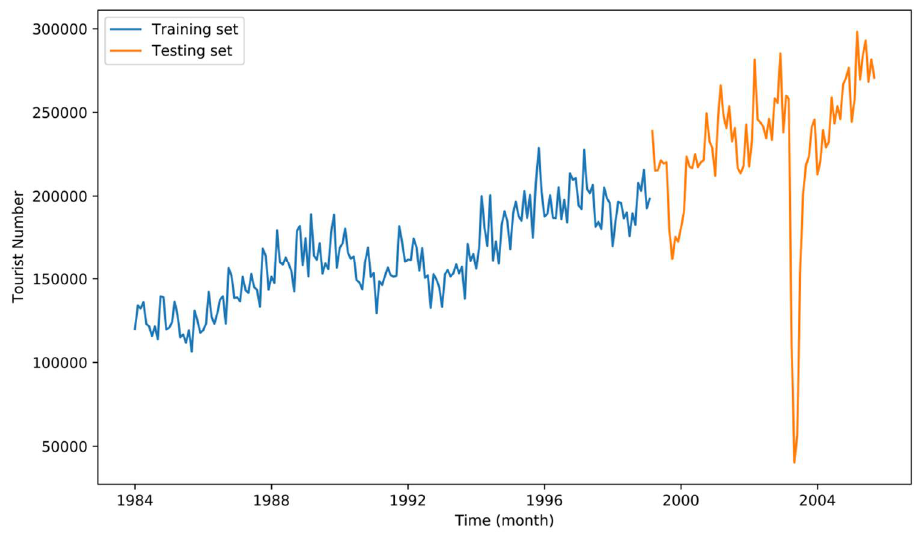
Figure 2. Monthly tourist number of Taiwan from January 1984 to September 2005.